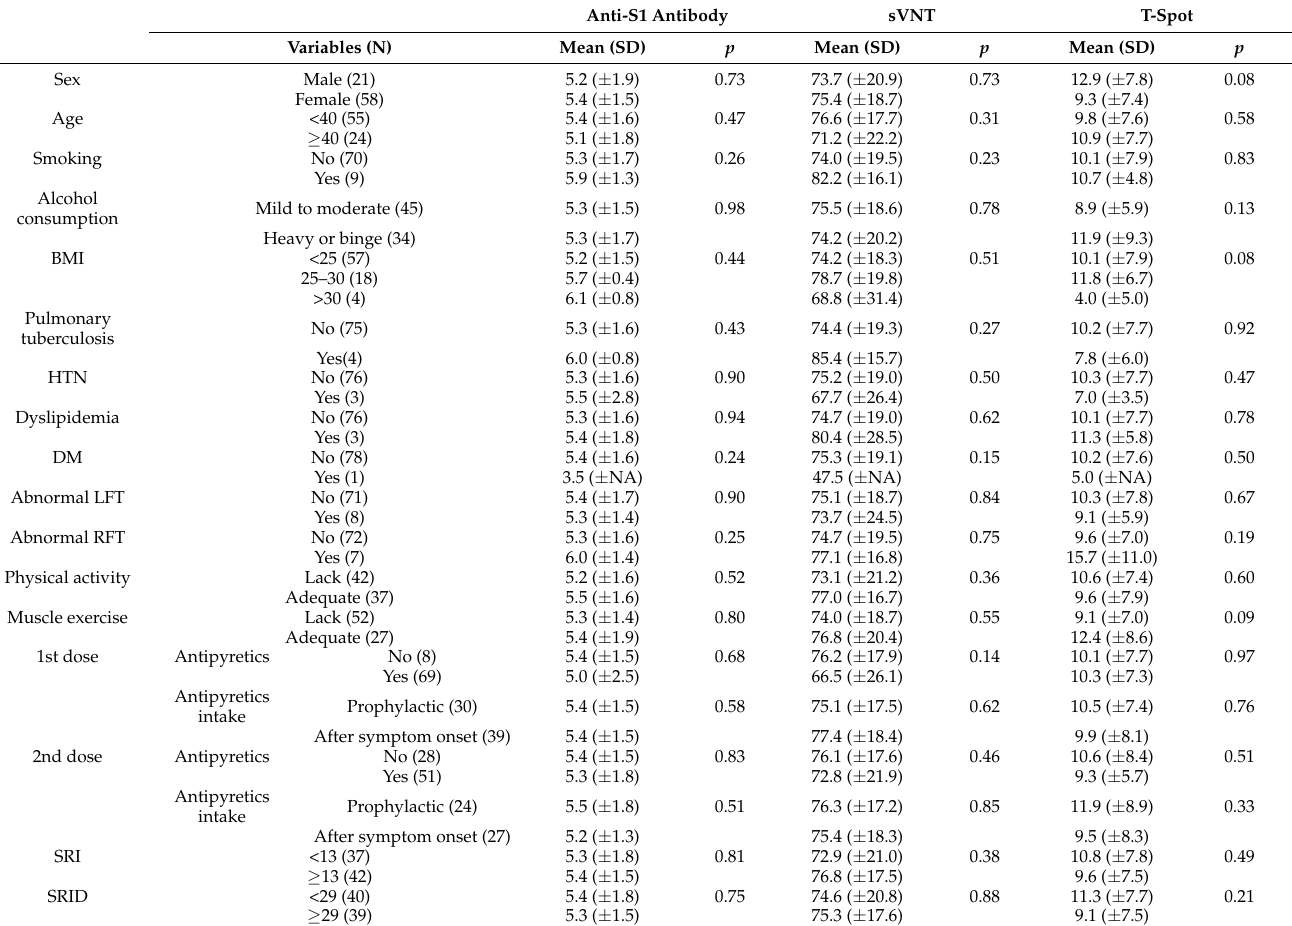
Table A2. The association between immunogenicity and individual’s health state, antipyretics, and reactogenicity index. Anti-S1 Antibody sVNT